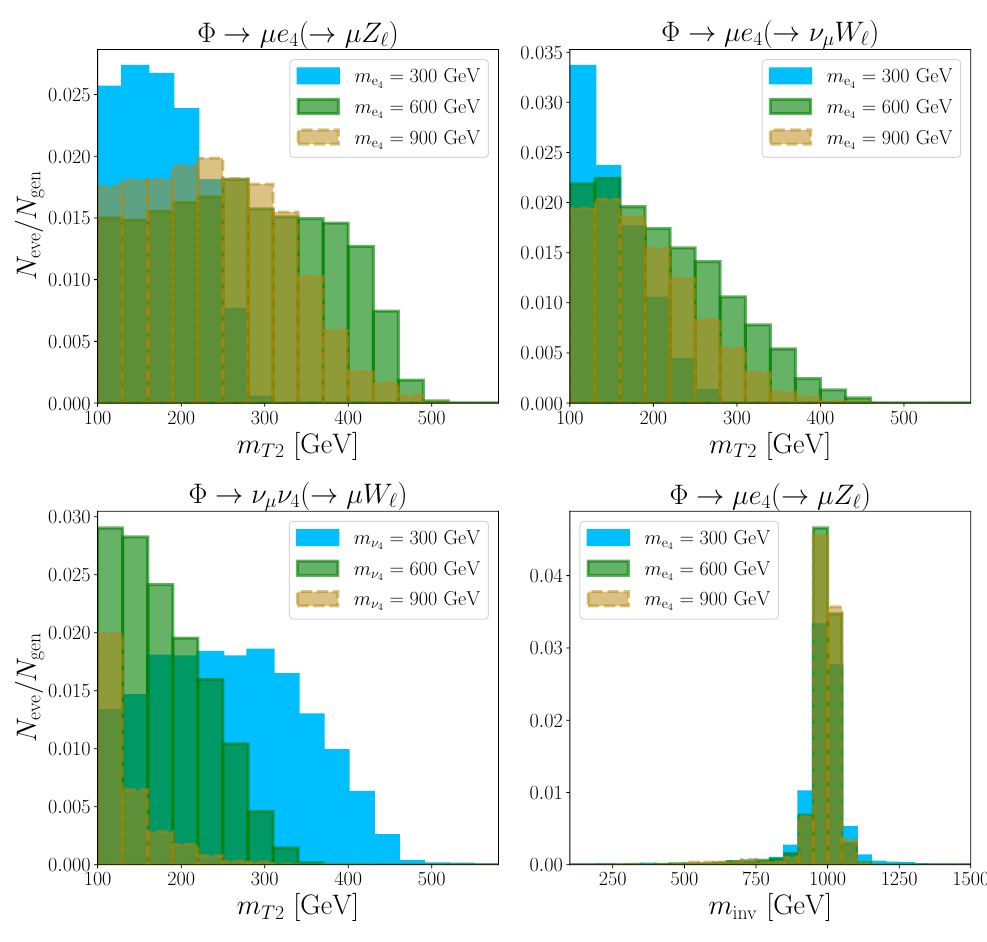
Figure 2 . m T 2 distributions of the Higgs cascade decays for m H = 1000 GeV and vectorlike lepton masses 300, 600, and 900 GeV. The left-lower panel shows the invariant mass of four leptons from the EZ